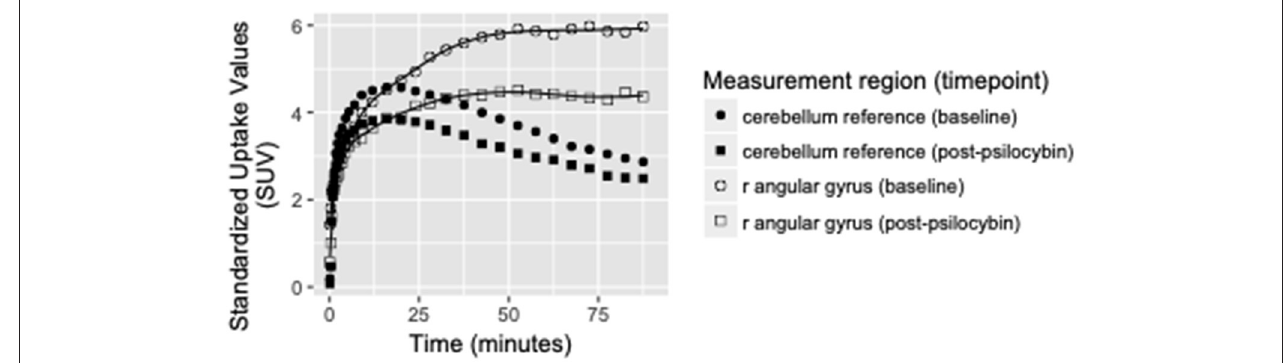
FIGURE 2 | Time activity curves at baseline and post-psilocybin time points for the right angular gyrus and the cerebellum reference region in a representative volunteer (S4, a 28-year-old male). Differences between baseline and post-psilocybin standardized uptake values demonstrate substantial blocking of [ 11 C]MDL 100,907 by psilocybin in the angular gyrus, but not in the reference region (as expected). Time activity curves for the right angular gyrus are representative of time activity curves for others regions with highest occupancy by psilocybin (including left angular gyrus, bilateral intraparietal sulcus, and subgenual anterior cingulate